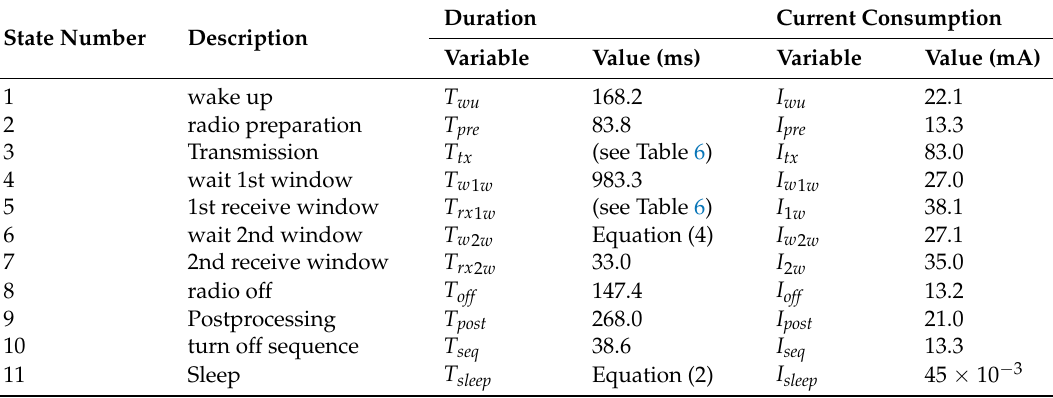
Figure 6. Current consumption profile of a MultiConnect mDot LoRaWAN end-device performing an unacknowledged transmission with DR0. The data message transmitted has a FRM Payload size of 51 bytes (i.e., maximum possible size for DR0). Table 5. States, variables and their values for LoRaWAN unacknowledged transmission.